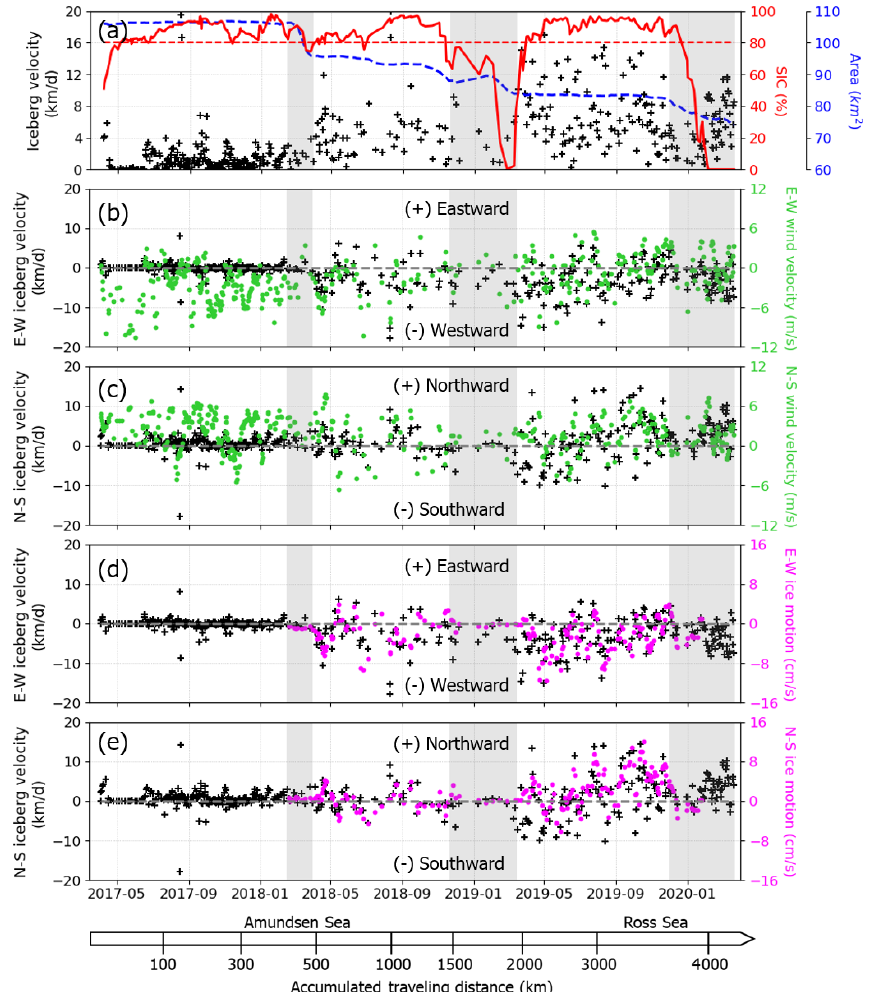
Figure 7. (a) Drift speed of the iceberg (black crosses), SIC (red solid line), and area changes (blue dashed line); (b) east–west velocity of both the iceberg (black crosses) and the wind (green circles); (c) north–south velocity of both the iceberg (black crosses) and the wind (green circles); (d) east–west velocity of both the iceberg (black crosses) and sea ice motion (magenta circles); (e) north–south velocity of both the iceberg (black crosses) and sea ice motion (magenta circles). Gray shaded areas indicate the split-off events of the